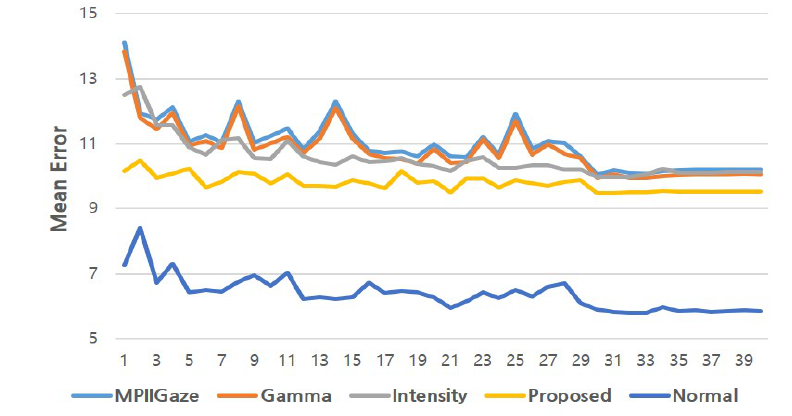
Figure 15. Changes in mean angular error according to the number of